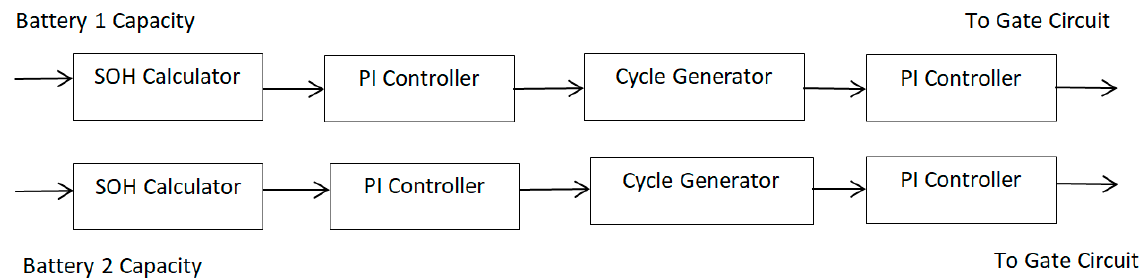
Figure 7. Control algorithm for SOH estimation.